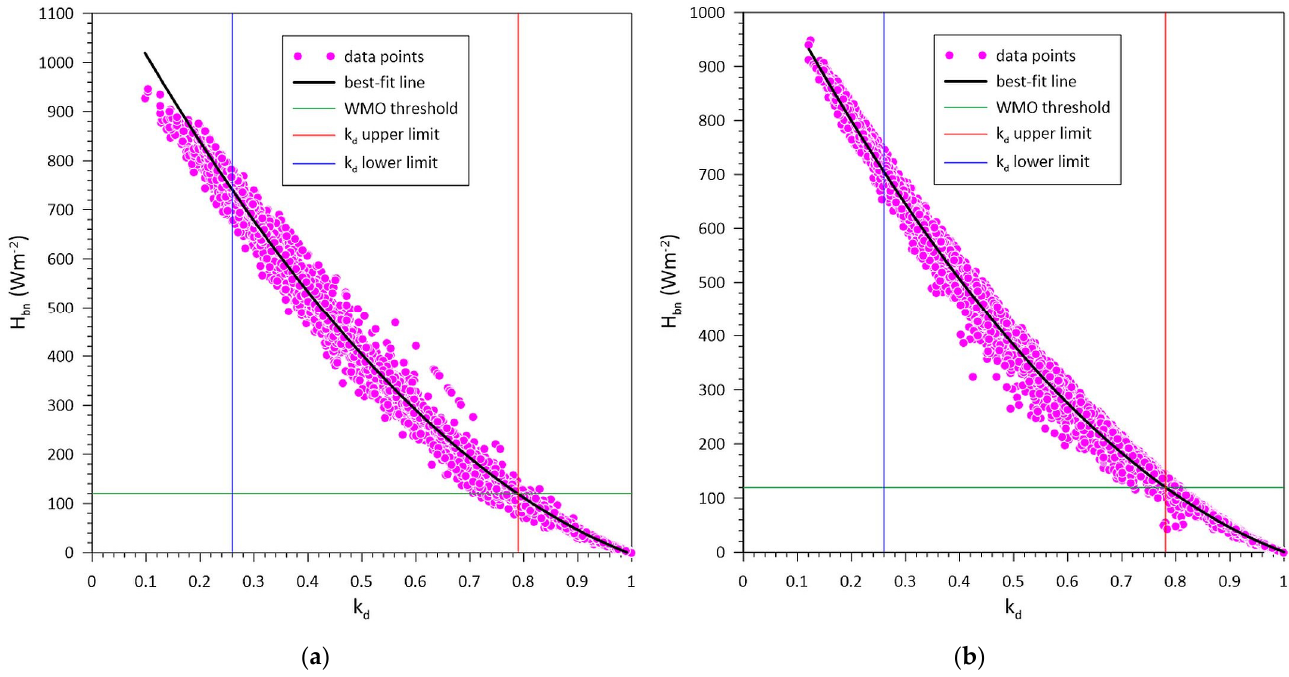
Figure 7. Determination of the k du (red line) and k dl (blue line) values for the ( a ) ILO and ( b ) KIS sites.